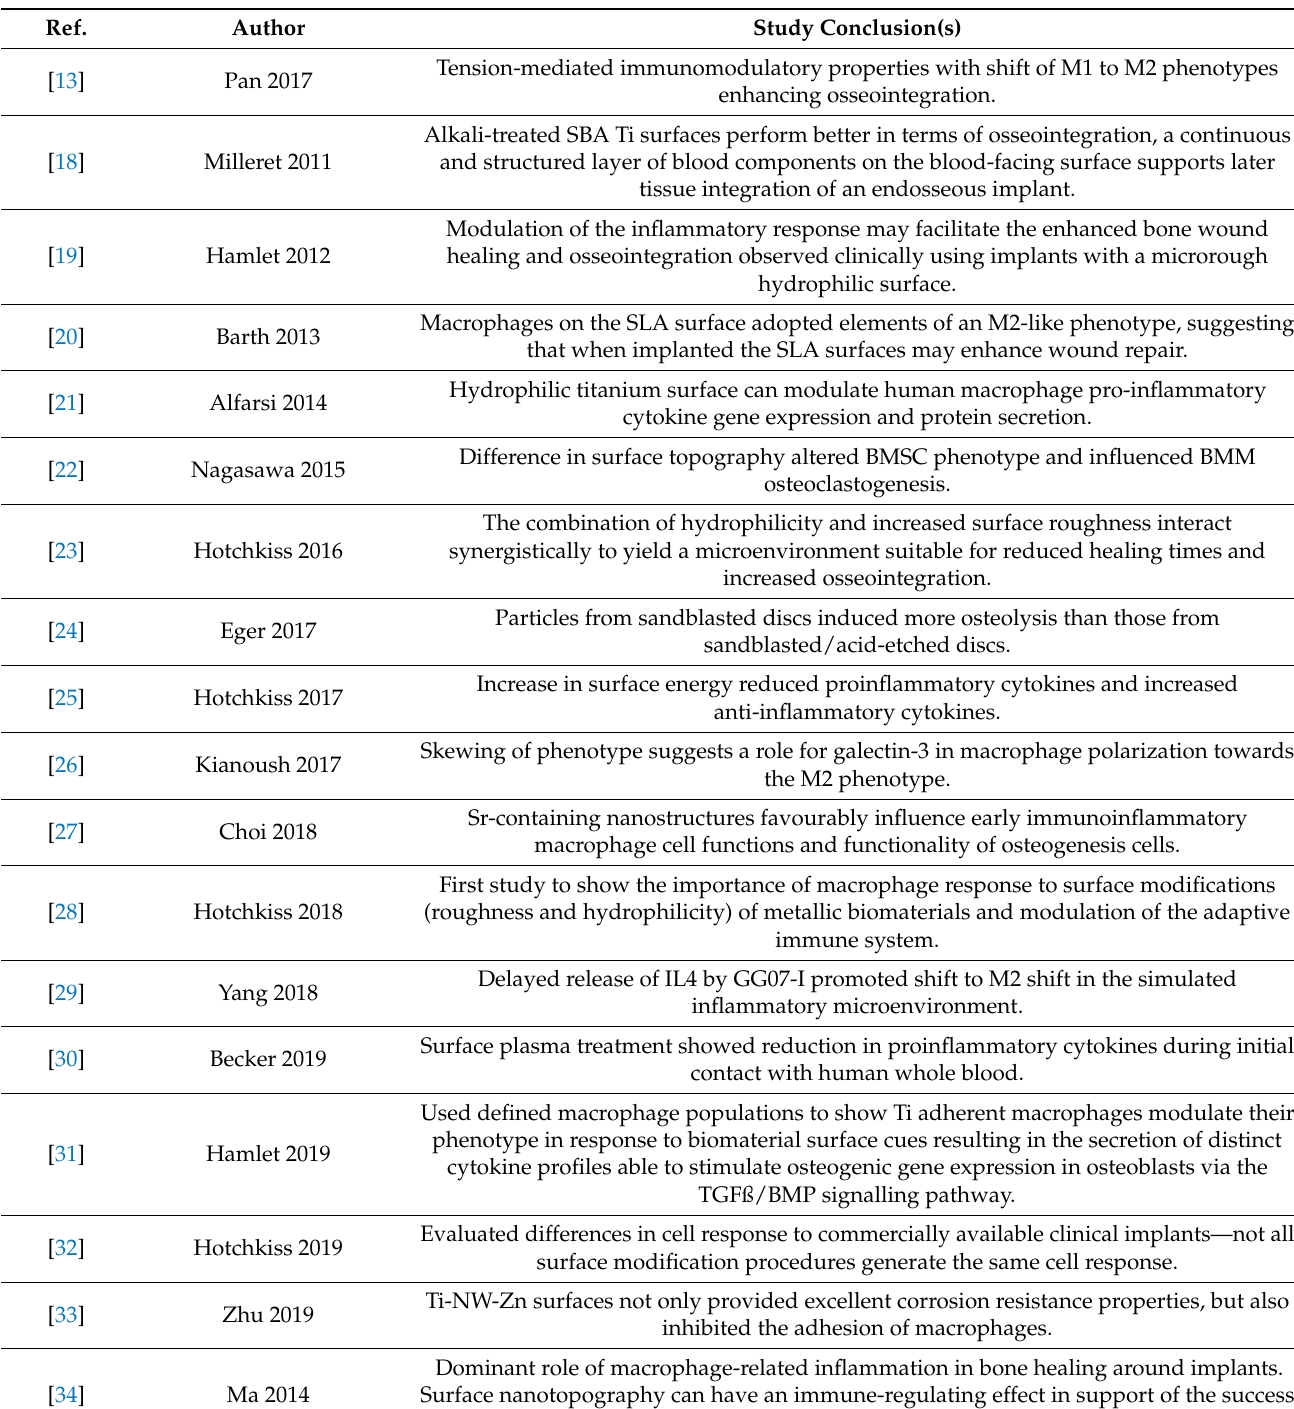
Table 6. Conclusions of studies included in